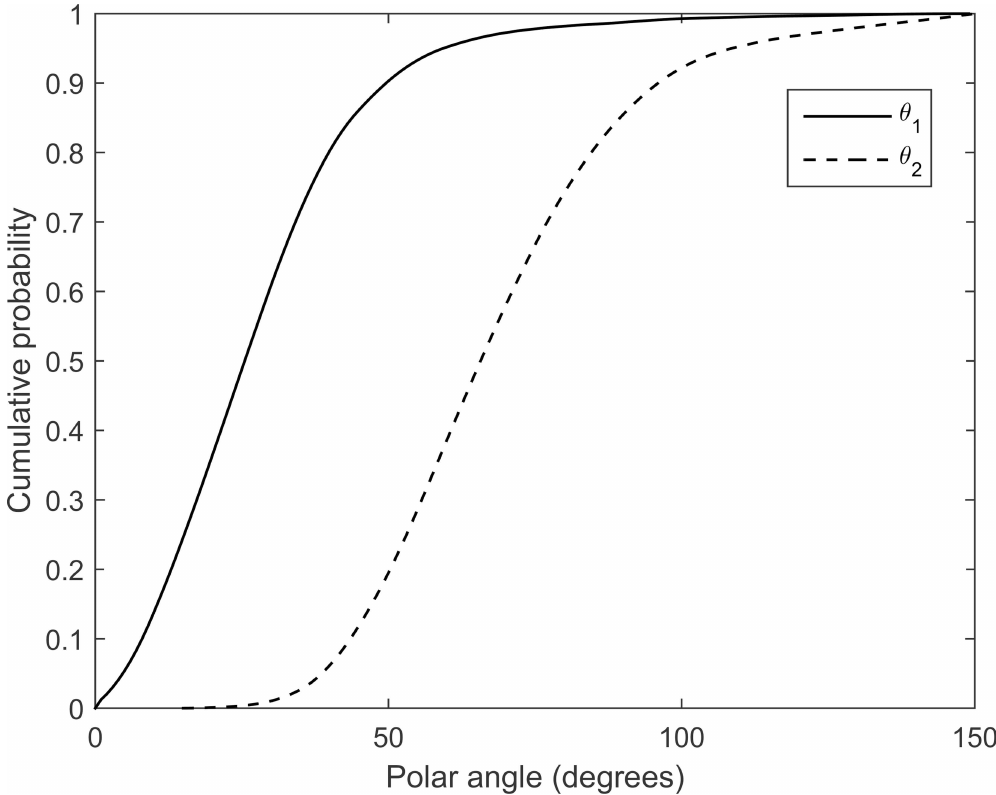
Fig 1. Angular distribution. The cumulative distributionfunction of the polar angles,accordingto Op Den Buijs et al., for the two branches.[9].